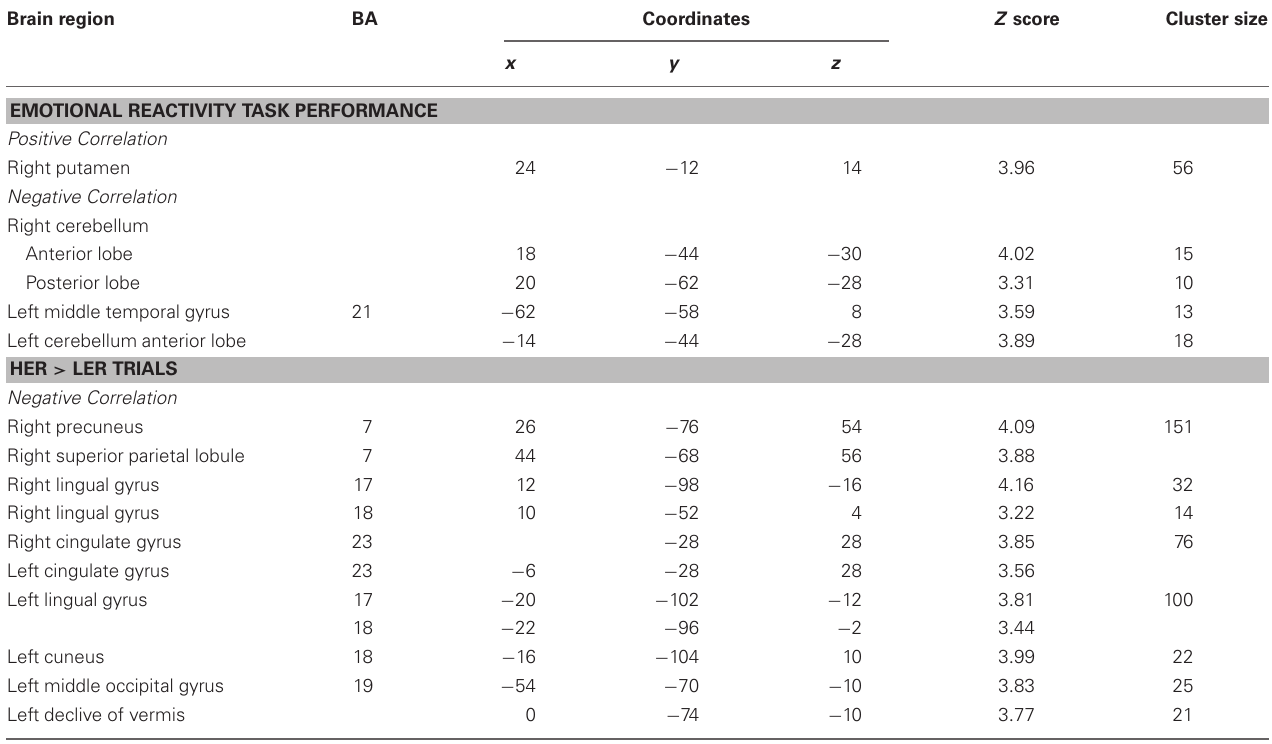
Table 4 | Result from the correlation analysis with percentage REM sleep. Brain region